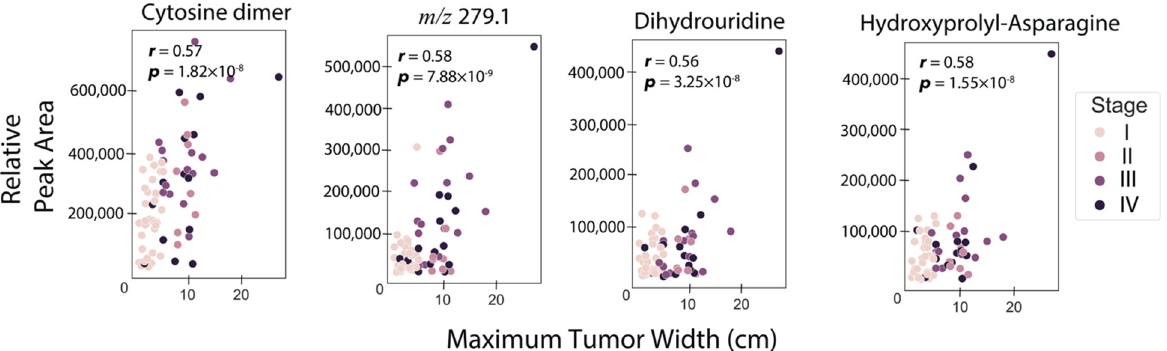
Figure 2. Metabolites with the highest correlation with maximum tumor width. Pearson correlation coefficient and p ‐ values for testing non ‐ correlation are provided. The threshold for the correlation coefficient was r > 0.55. Table 2. Compound annotation for the metabolites with the highest correlation ( r >0.55) with RCC tumor size. ID no.